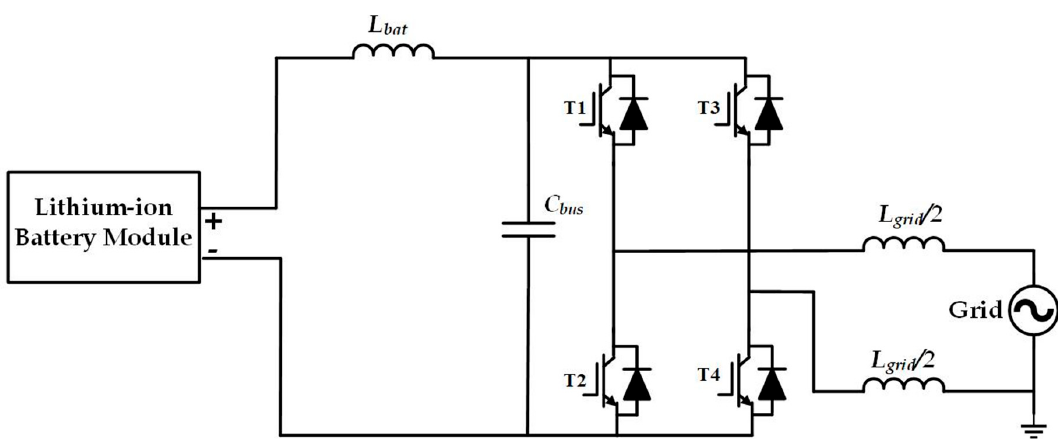
Figure 14 . Simulink model of the FB for Light-Duty Vehicles. Figure 14. Simulink model of the FB for Light-Duty Vehicles. Table 6. Main characteristics of the Light-Duty system connected to HV Batteries.